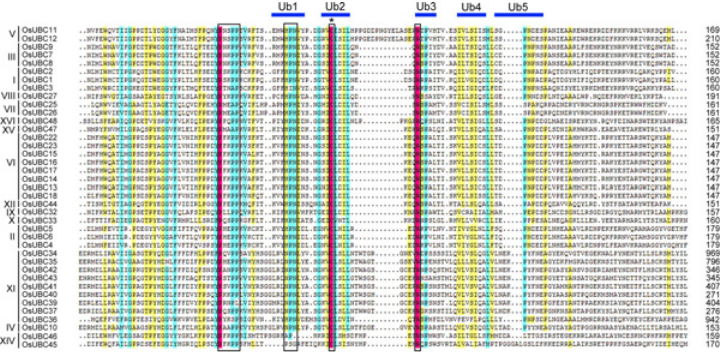
Fig 3. Multiple sequence alignment of UBC domain in OsUBCs. Identical, conservative and block of similar amino acid residues are shaded in red, light blue and yellow, respectively. The asterisk symbol above the alignment indicates the conserved active-site cysteine of UBCs. The conserved motifs are bordered (black rectangles), including PxxPP motif and HPN tripeptide motif. Ubiquitin thioester intermediate interaction residues are marked by blue lines and shown as